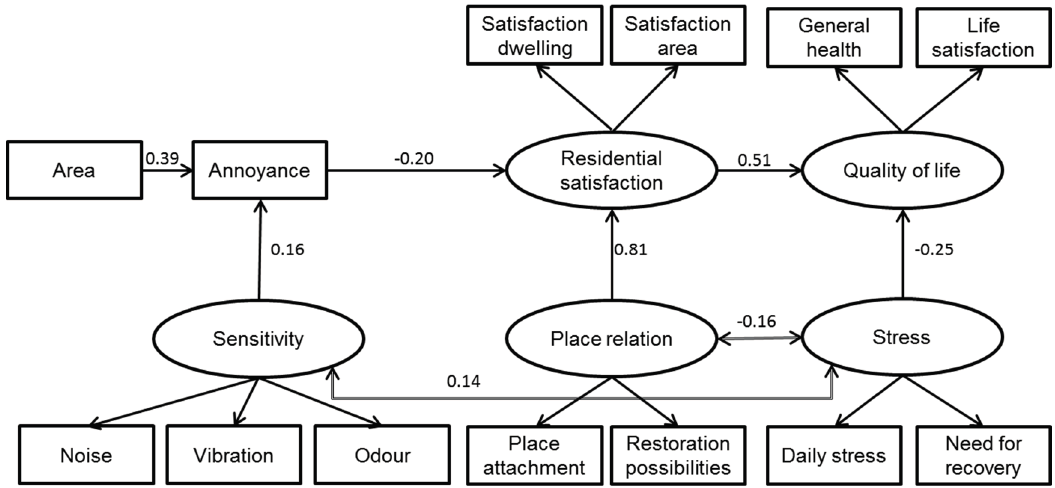
Figure 3. Structural equation model of the relationship between area, annoyance and quality of life, with mediating and moderating